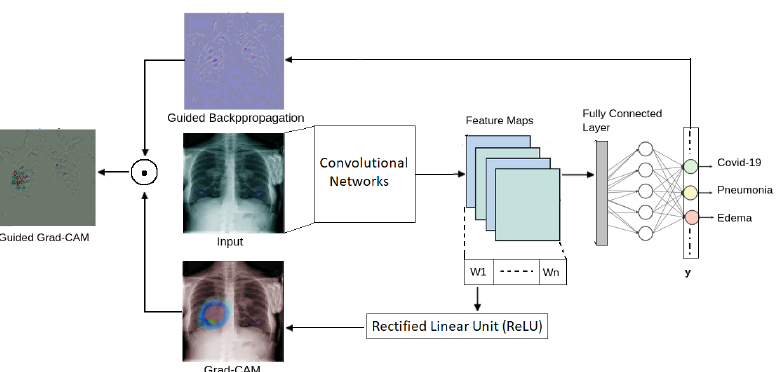
Figure 3. Conceptual view of guided gradient class activation mapping. Guided Grad CAM combines gradient information from the last convolutional layer and guided backpropagation for creating high resolution heat